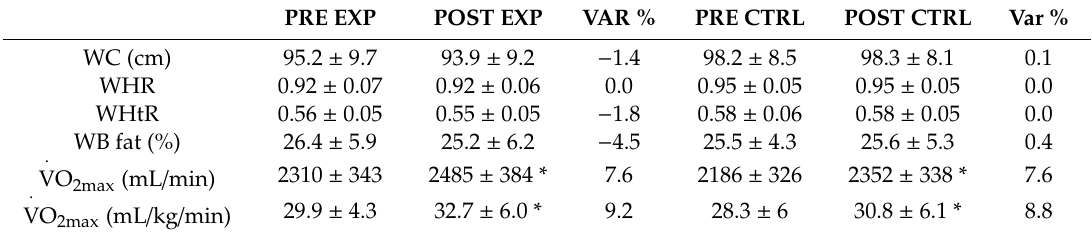
Table 2. Anthropometric and physiologic variables pre- and post-intervention (mean ±